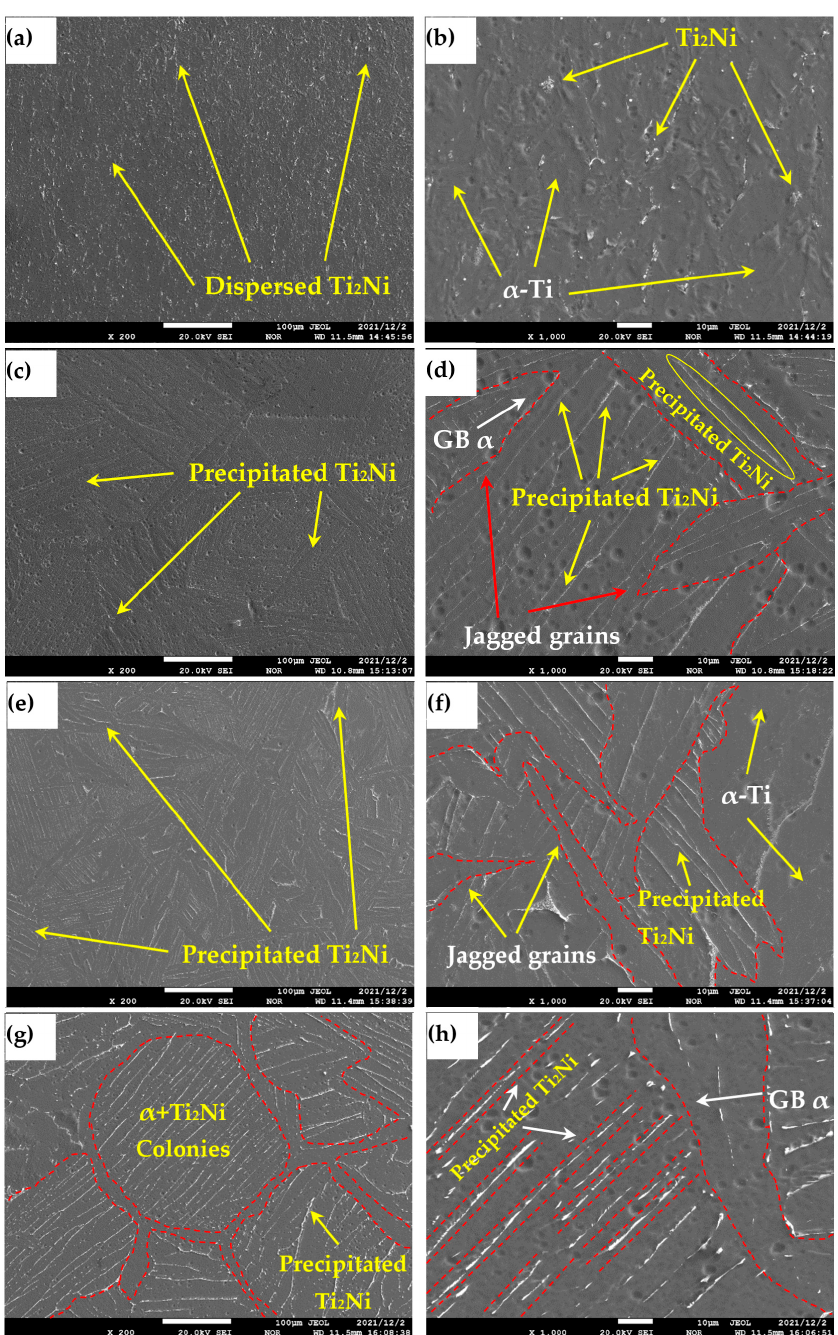
Figure 1. SEM photographs of Ti-0.3Ni sheets treated by different processes in various magnifi- cation in SE imaging mode: ( a , b ) as-cold rolled, ( c , d ) treated at 950 ◦ C/1 h/WC, ( e , f ) treated at 950 ◦ C/1 h/WC + 500 ◦ C/3 h/AC and ( g , h ) treated at 950 ◦ C/1